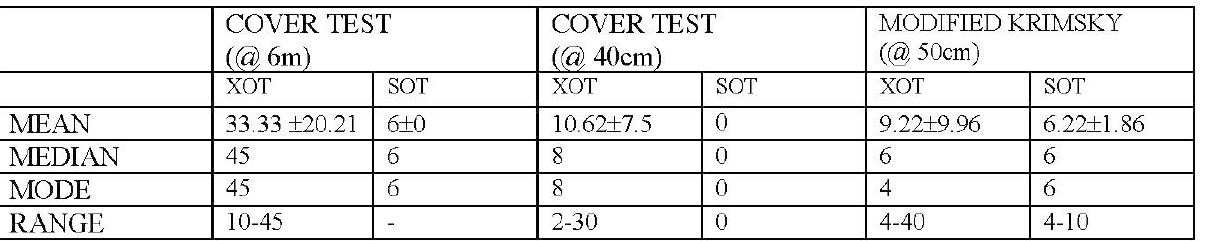
Table 2: Magnitude of the strabismus detected in the sample using the three tests. All measurements are in prism dioptres (pd).